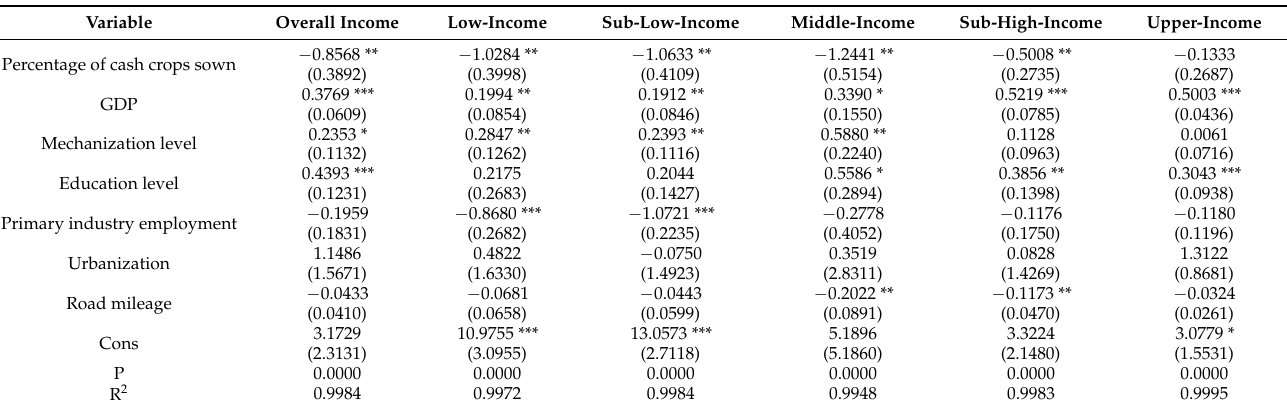
Table 5. Robustness test 2: Change in explanatory